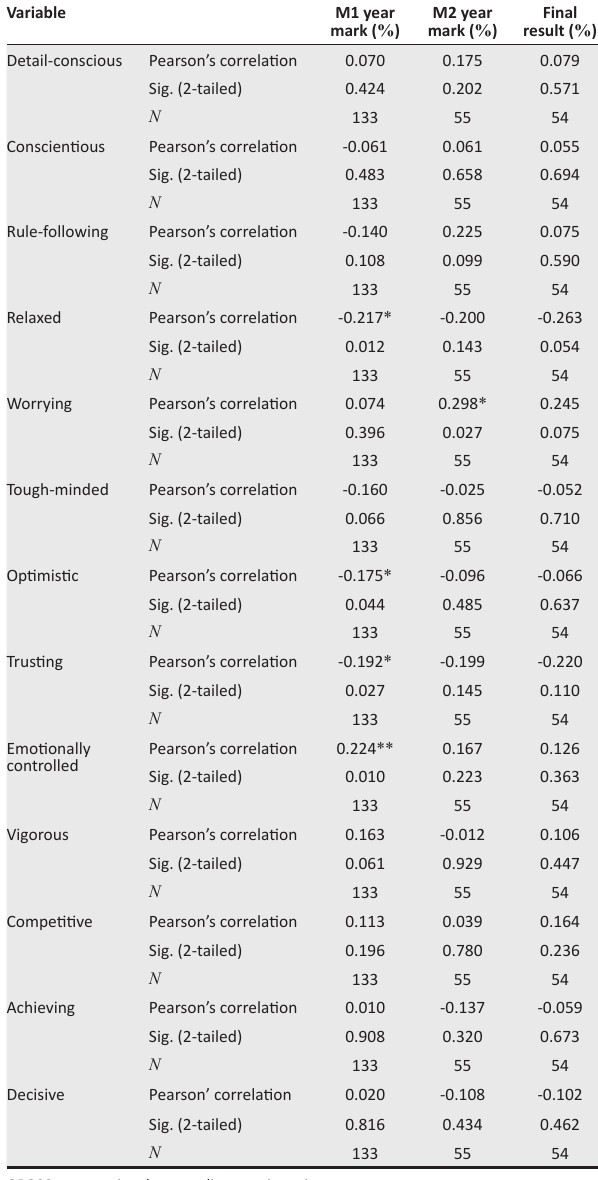
TABLE 6: Pearson’s correlation between academic success and the occupational personality questionnaire sten scores. Variable